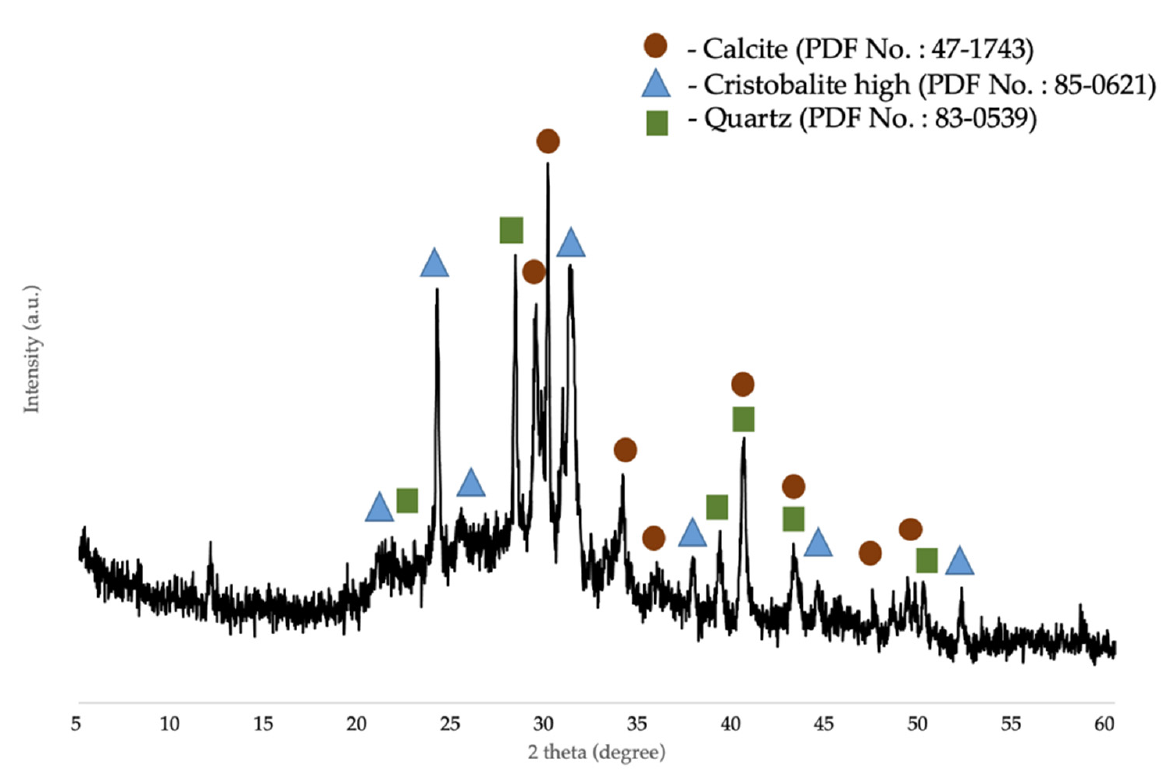
Figure 3. XRD patterns of raw corn stover ash (as received).